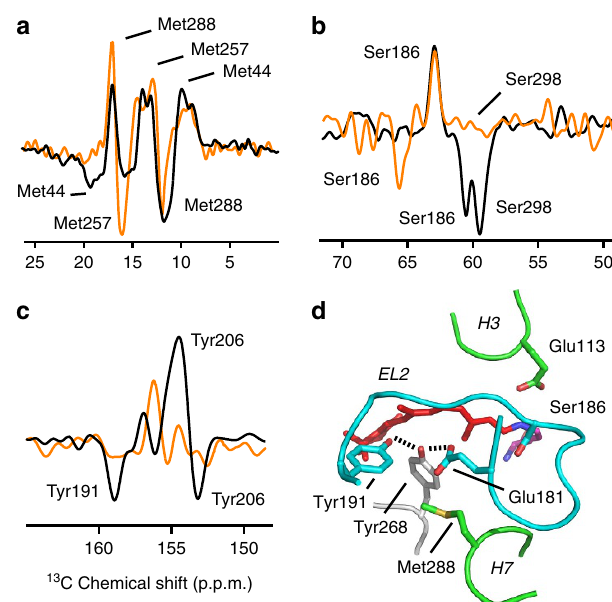
Figure 3 | Changes in EL2 interactions in Meta-I and Meta-II. 1D NMR difference spectra are shown of rhodopsin minus Meta-I (orange) and rhodopsin minus Meta-II (black) using rhodopsin containing labelled 13 C e -Met ( a ), 13 C b -Ser ( b ) or 13 C z -Tyr ( c ). The rhodopsin spectra correspond to positive peaks, while the Meta-I and Meta-II spectra correspond to negative peaks. The assignments of the resonances have previously been reported 18,19,38,64 . ( d ) Crystal structure of rhodopsin in the region of Tyr268 6.51 (PDB-ID 1U19; ref. 26).